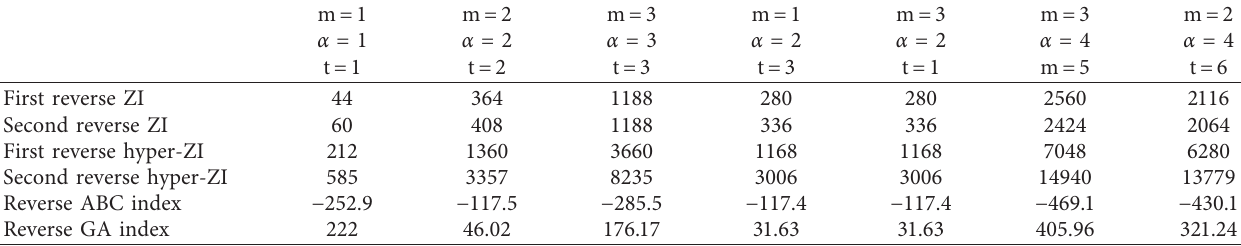
Table 1: Values of calculated topological indices of Cu